Question: Provide a one-line summary of what is displayed.
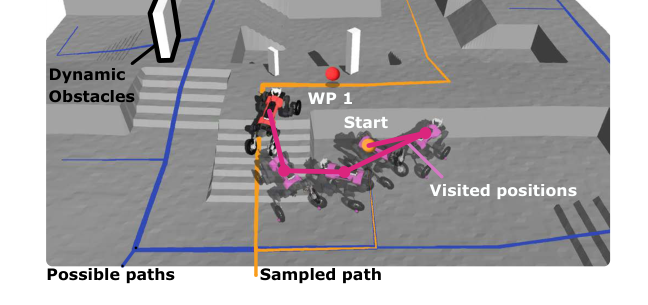
Answer: System overview. (A) Our wheeled-legged quadrupedal robot is equipped with various payloads for onboard terrain mapping, obstacle detection, and localization. (B) Overview of the navigation system. The system is driven by two neural network policies oper- ating at different levels. The high-level navigation policy observes two waypoints (WP 1 and WP 2) and generates target velocity com- mands for the locomotion policy. The low-level locomotion policy then controls joint actuators and follows the velocity commands. (C) Our training environment is designed to dynamically generate new navigation paths for each episode, optimizing the learning process. By leveraging pre-generated obstacle-free paths, we enhance the nav- igation capabilities of our system.